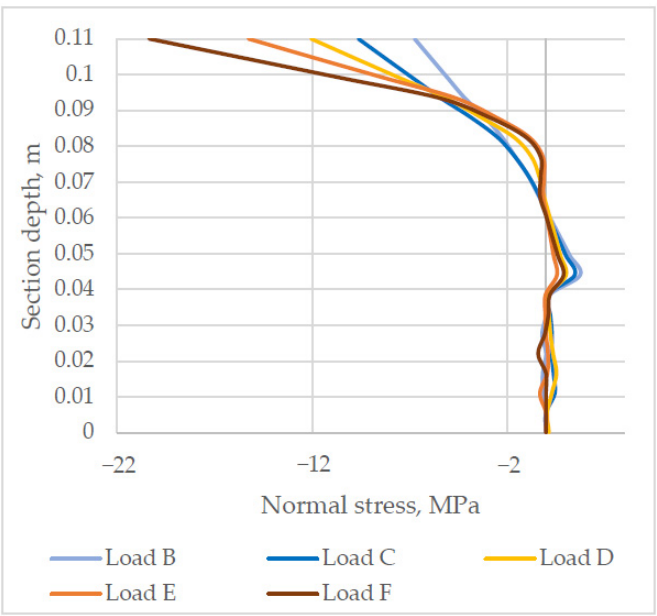
Figure 14. Normal stress distribution in section (cid:1845) (cid:3026)(cid:3026)(cid:2871) (negative stress values = compression).